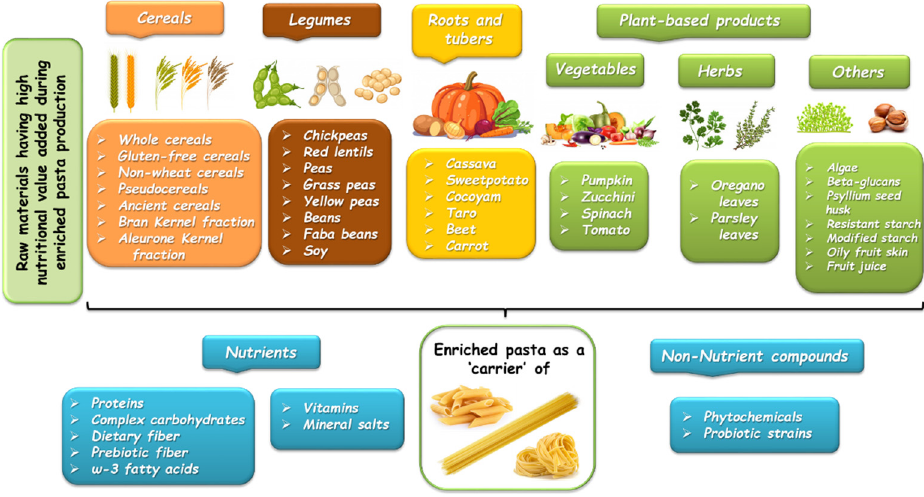
Figure 1. Raw materials commonly employed to produce enriched pasta product at high nutritional